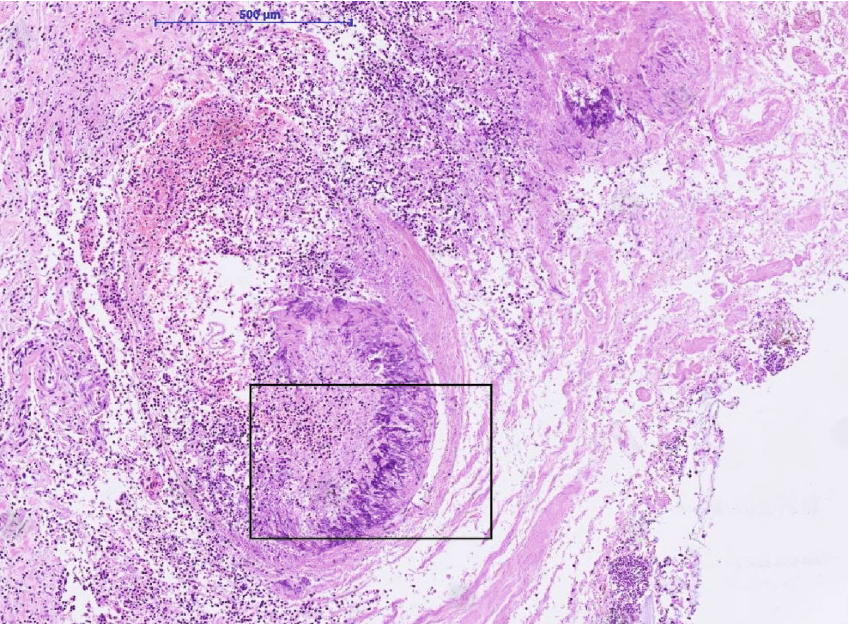
Figure 1: Hematoxylin-eosin staining of ulcers of the small intestine with intravascular aspergillus manifestation (4x magni fi